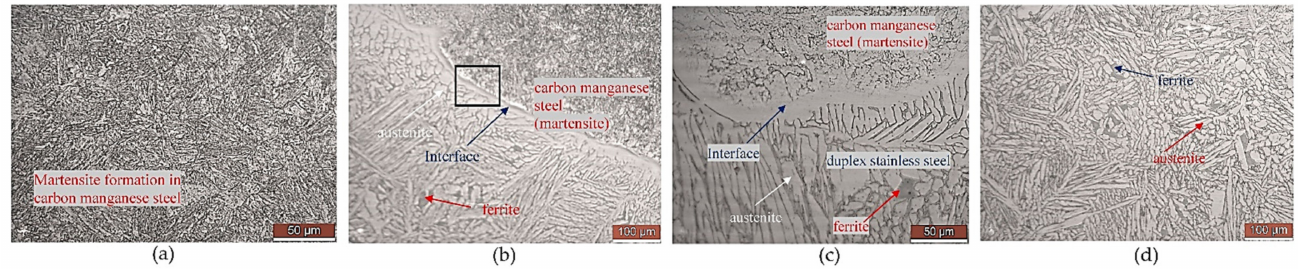
Figure 8. Microstructure of carbon-manganese and duplex stainless steel joint achieved by CMT technique: ( a ) in C-Mn steel; ( b ) at C-Mn steel—duplex SS interface (100 µ m); ( c ) at C-Mn steel—duplex SS interface (50 µ m); ( d ) in duplex SS. Reprinted with permission from Ref. [16]. Copyright 2020